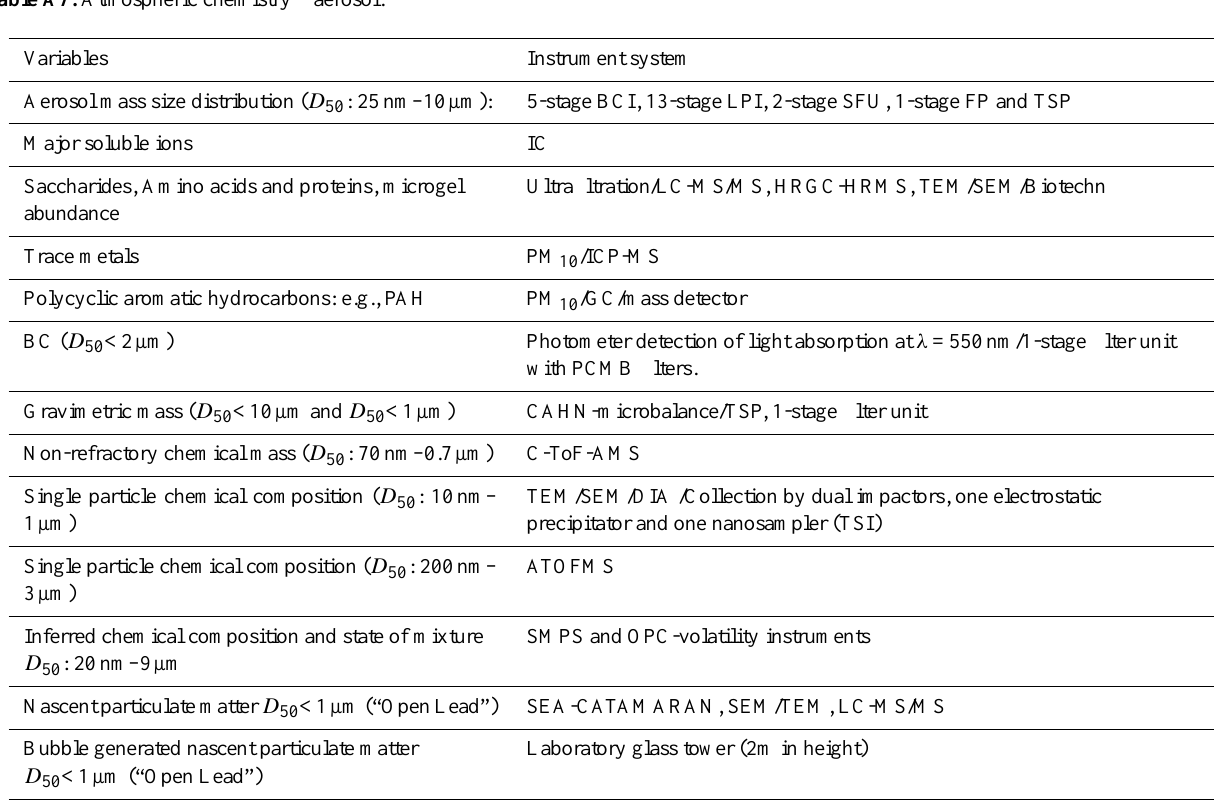
Table A7. Atmospheric chemistry –